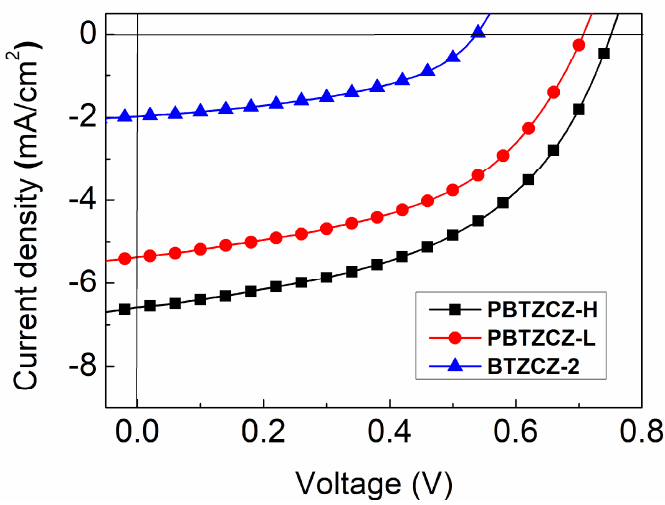
Figure 4. J-V characteristics of the BTZCZ-2 -, PBTZCZ-L -, and PBTZCZ-H -based solar cell devices. Table 2. Photovoltaic performances of the conventional and inverted devices based on the PBTZCZ-H , PBTZCZ-L , and BTZCZ-2 with PC 71 BM